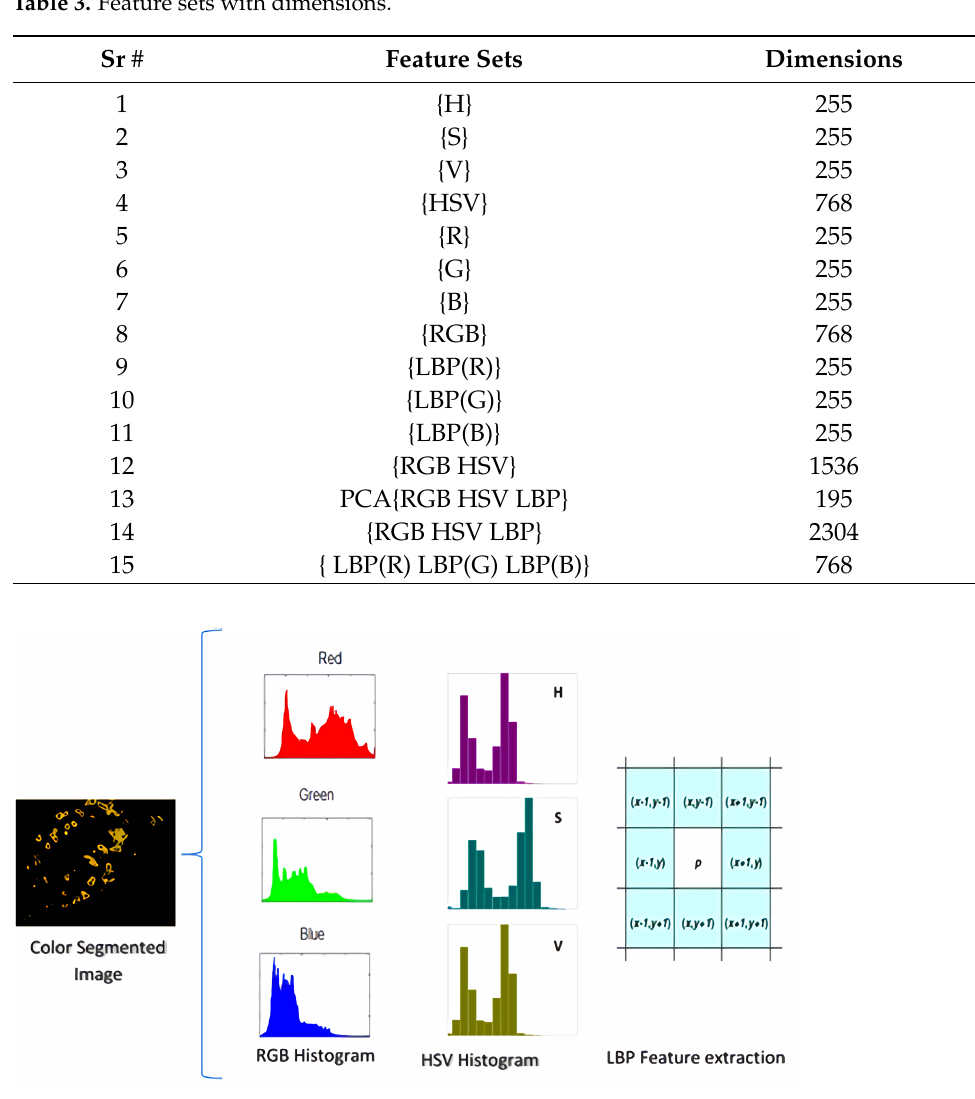
Table 3. Feature sets with dimensions.